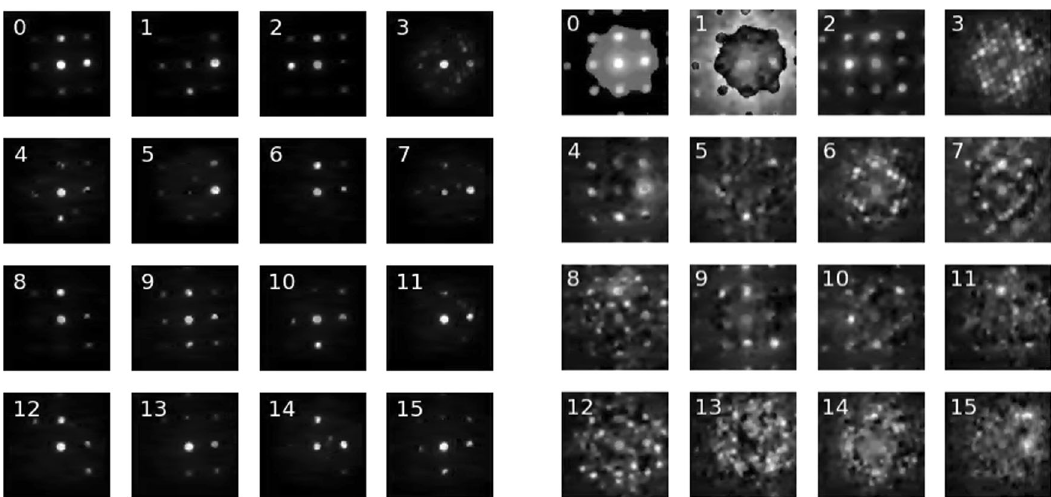
Fig. 10 Comparison of ef fi cacy of NMF using different inputs. The 16 principal components were extracted: from the masked precipitates on the Al alloy dataset (left); and from the redistributed dataset generated from decoding the latent-space of the masked precipitates on the Al alloy dataset (right).